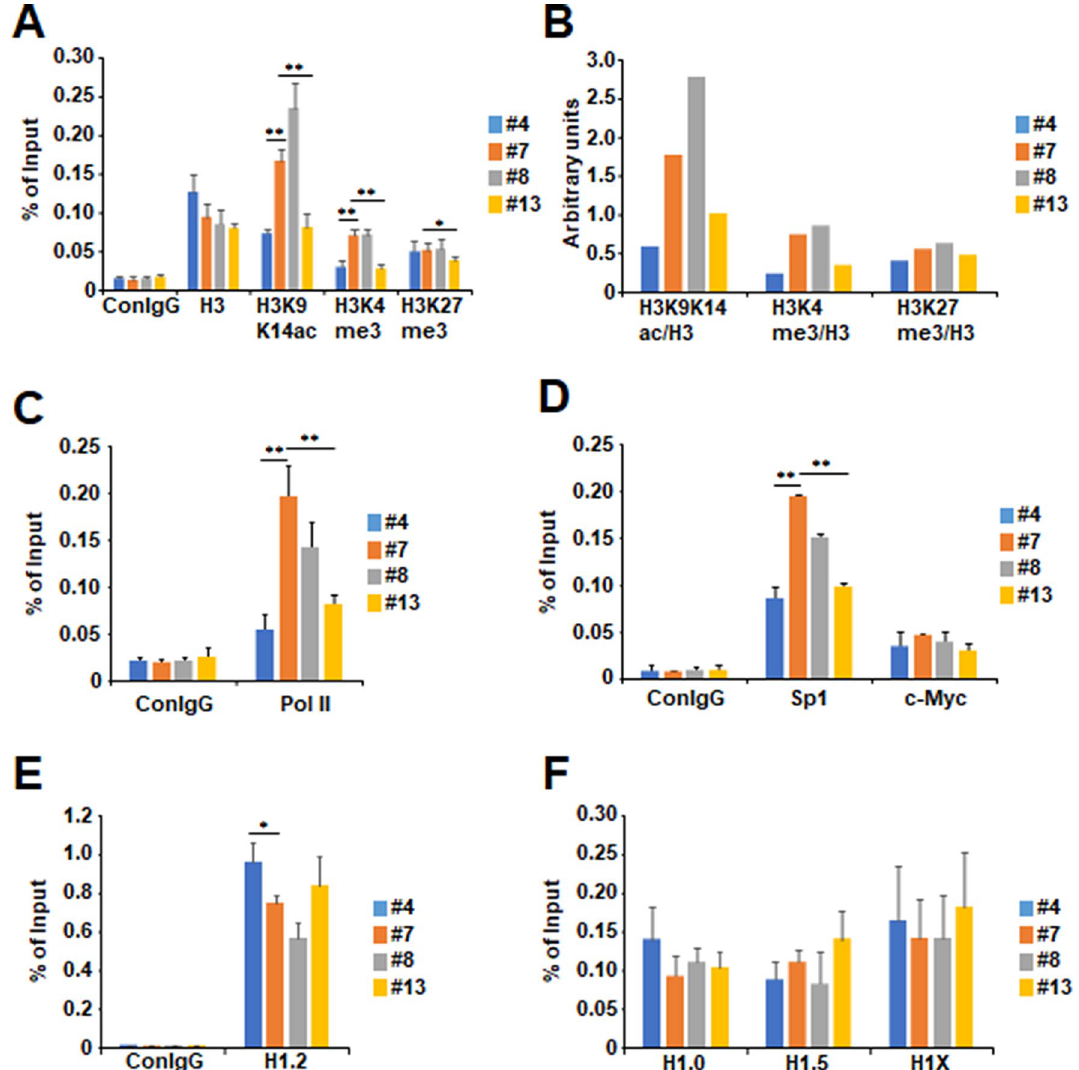
Figure 6. Histone modifications and Sp1 involved in transcriptional activation on TERT promoter were decreased in TAF-I KD HeLa cell lines independently of histone H1 amounts. ChIP assays were performed using WT and TAF-I KD HeLa cell lines. ( A ) The level of histone H3, H3 acetylated K9 and K14 (H3K9K14ac), H3 trimethylated K4 (H3K4me3), and H3 trimethylated K27 (H3K27me3) around the TERT TSS including core promoter was examined. Rabbit normal IgG was used as a control for monitoring background (ConIgG). Data were represented as % of input at vertical line. Values represent the mean ± SD (n = 3). ** P < 0.01 and * P < 0.05 relative to #7. ( B ) The value of each histone H3 modification was normalized by that of histone H3. Arbitrarily units were represented at vertical line. ( C , D ) The level of rabbit normal IgG (conIgG), RNA polymerase II (pol II), Sp1, and c-Myc around the TERT TSS including core promoter was examined. Values represent the mean ± SD (n = 3). ** P < 0.01 relative to #7. ( E , F ) The level of rabbit normal IgG, histone H1.2, H1.0, H1.5, and H1X around the TERT TSS including core promoter was examined. Due to the difference of scale of vertical line, data were separately represented for histone H1.2 ( C ) and other histone H1s ( D ). Values represent the mean ± SD (n = 3). * P < 0.05 relative to